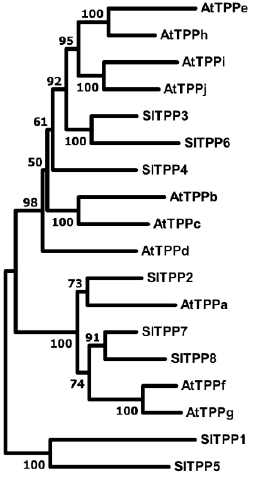
Figure 4. Phylogenetic tree of the TPP-families from tomato and Arabidopsis inferred using the Neighbor-Joining method. The bootstrap consensus tree inferred from 500 replicates. Evolutionary analyses were conducted in MEGA11 (www.megasoftware.net, accessed on 24 July 2022).